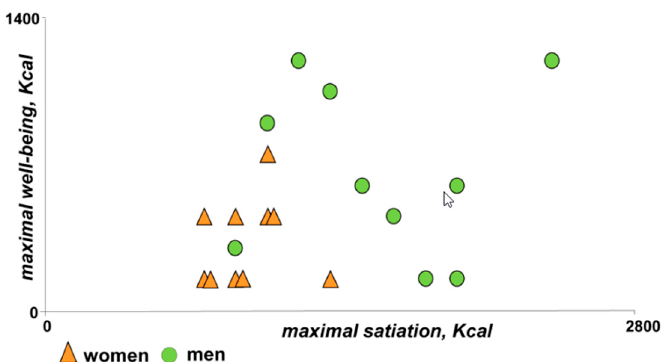
Figure 4. Relation between meal loads that induced maximal well-being and full satiation. Note discrimination between women and men.